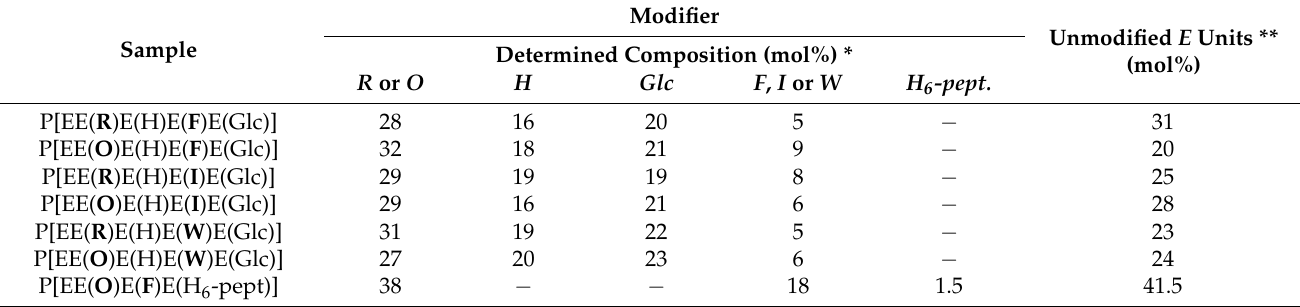
Table 1. Composition of the amphiphilic copolymers, as determined by quantitative HPLC amino acid analysis.